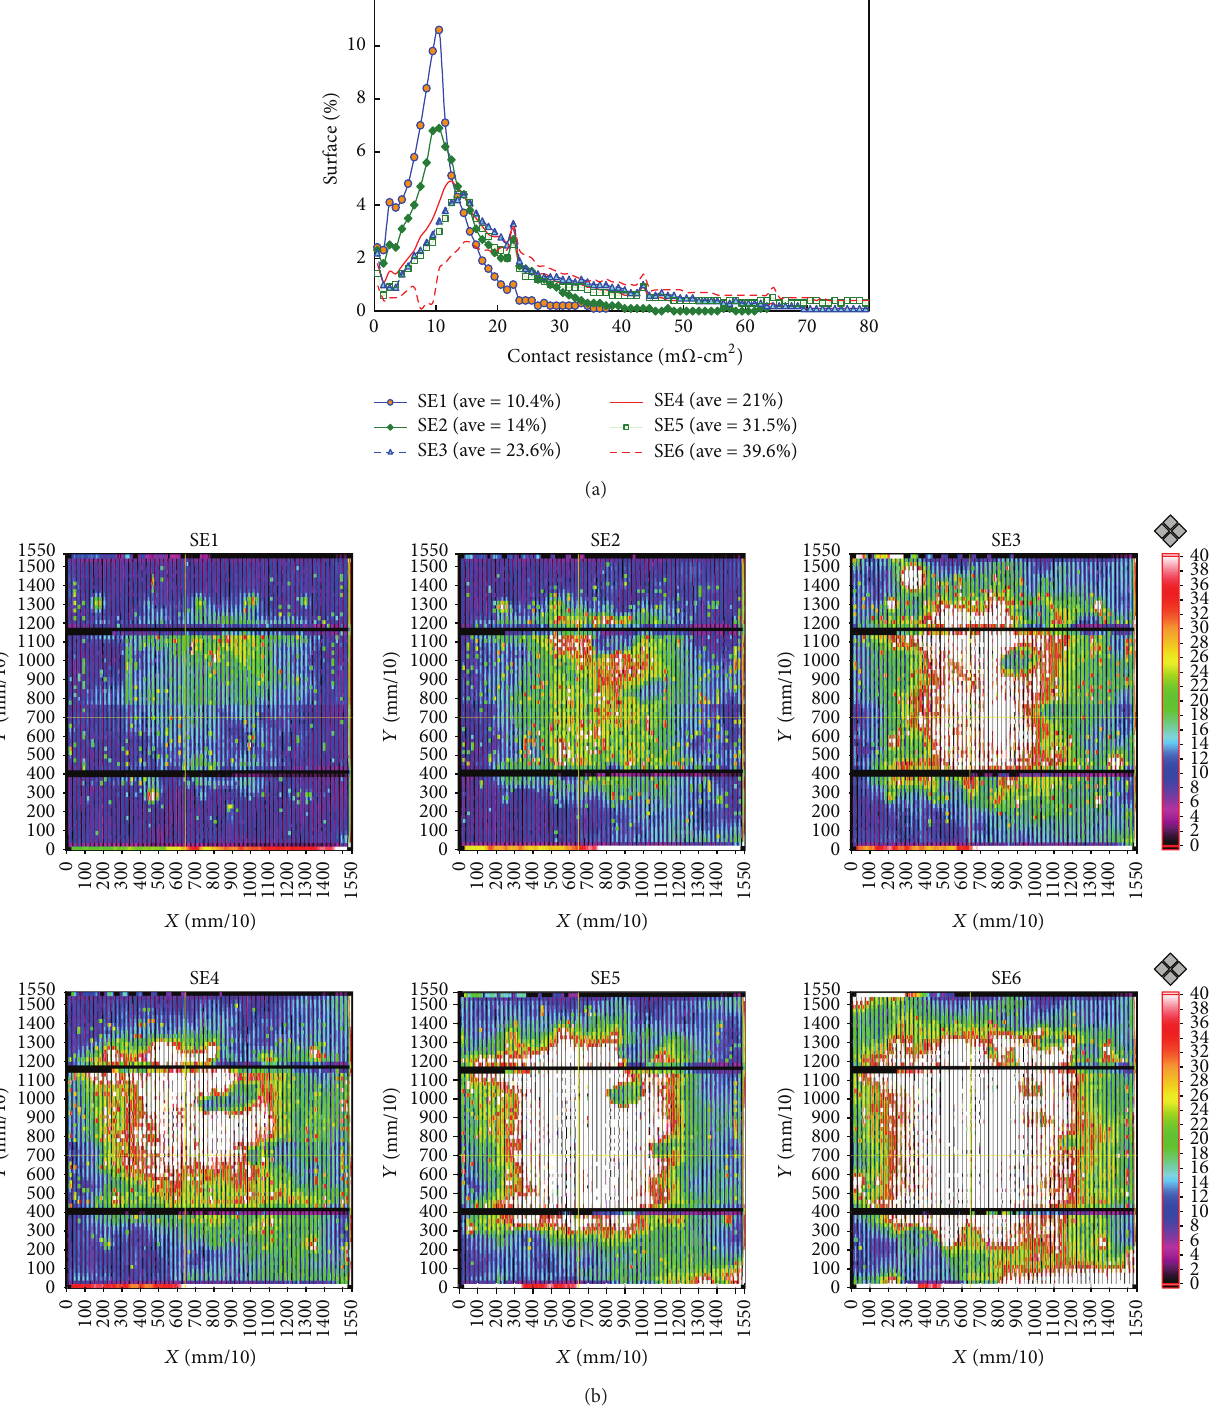
Figure 8: (a) Comparison of contact resistance (m Ω -cm 2 ) with the average percentage of occupied surface minority carriers (%) for six SE samples and (b) corresponding real-distribution maps of contact resistance profiles. The left-down point is the origin of 𝑋 - 𝑌 coordinates which means the scan size of cells, from 0 to 1500 (extreme = 1550) with interval of 100, and scale is mm/10. The right 𝑦 -axis (color chart) represents resistance values (in m Ω -cm 2 ), from bottom (0 for dark purple) to top (40 for bright red) with interval of